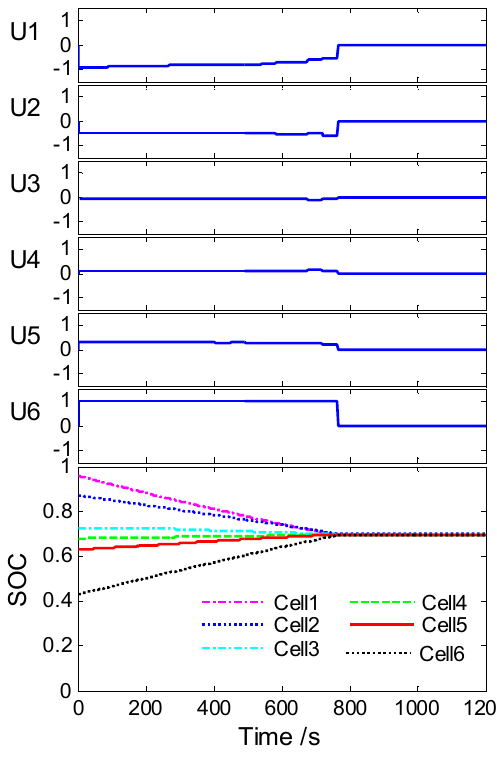
Figure 23. Based on the MPC.